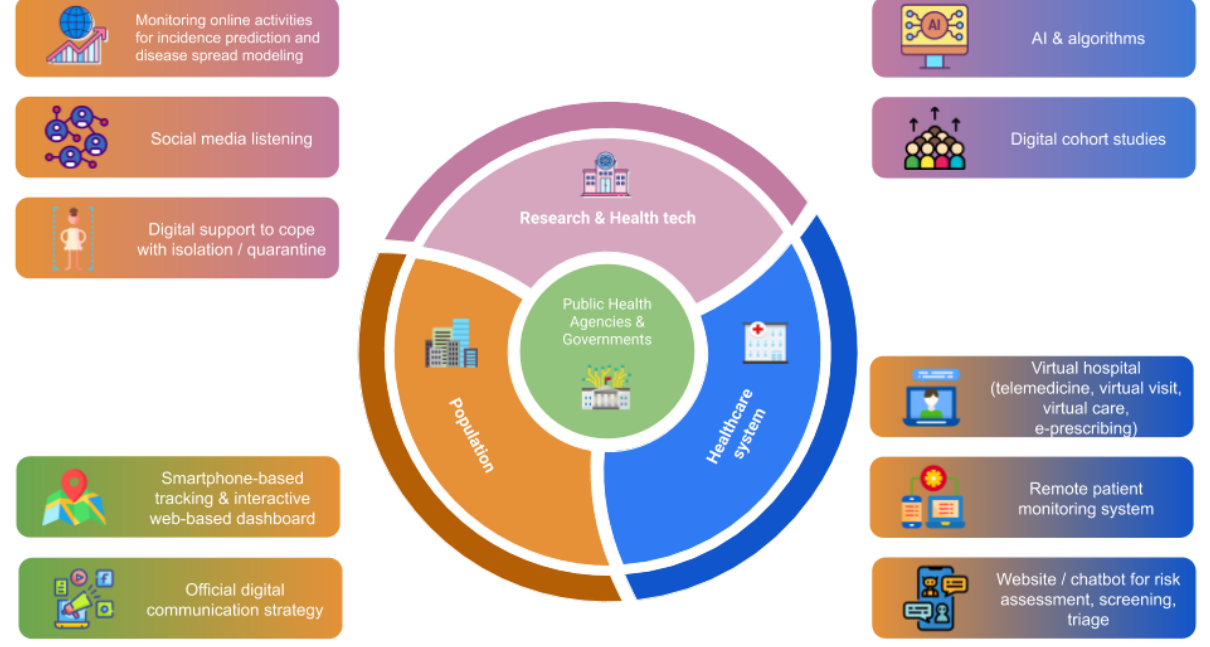
Figure 1. The COVID-19 digital health ecosystem. AI: artifical intelligence; e-prescribing: electronic prescribing; tech: